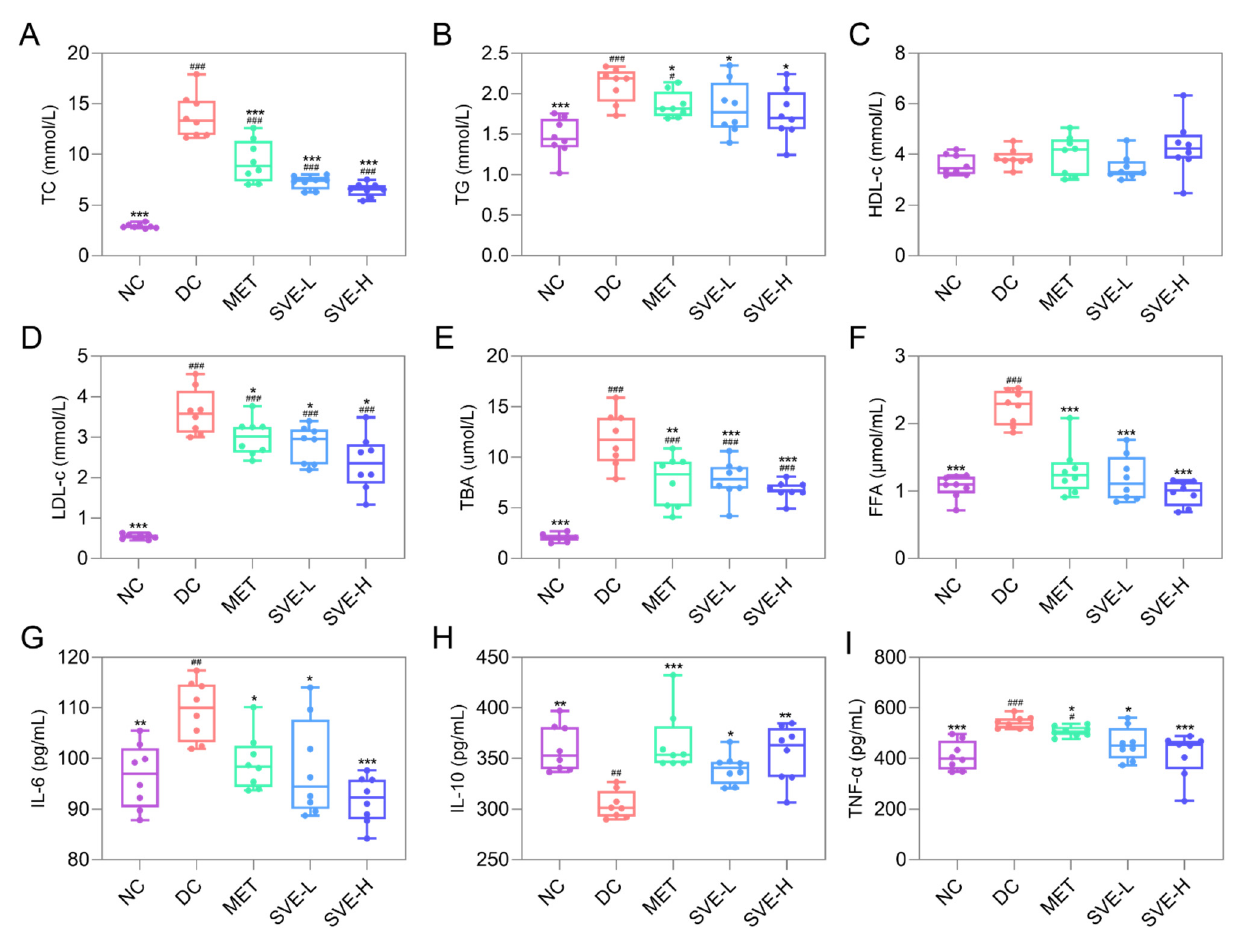
Figure 2. Effects of SVE intervention on the TC ( A ), TG ( B ), HDL-c ( C ), LDL-c ( D ), TBA ( E ), FFA ( F ), IL-6 ( G ), IL-10 ( H ), and TNF- α ( I ) in STZ-induced diabetic mice. Note: # p < 0.05, ## p < 0.01, and ### p < 0.001 versus the NC group; * p < 0.05, ** p < 0.01, and *** p < 0.001 versus the DC group.